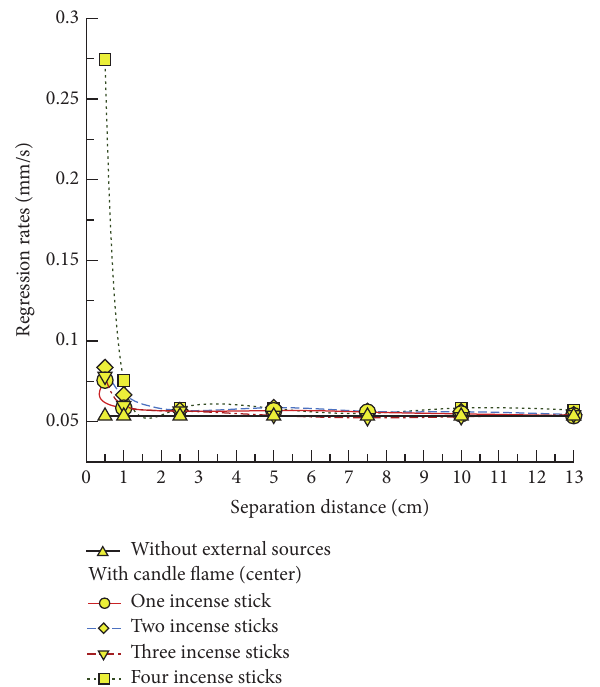
Figure 5: Effect of varying external heat sources and pilot fuel configuration on smoldering regression